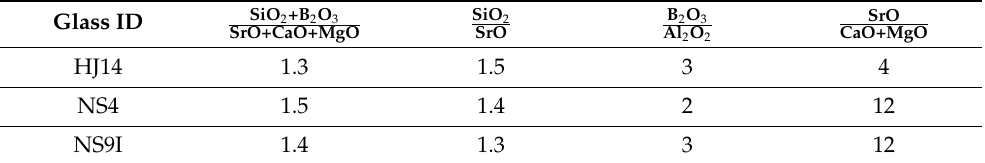
Table 1. Relevant correlations between the different components of the glass systems. Glass